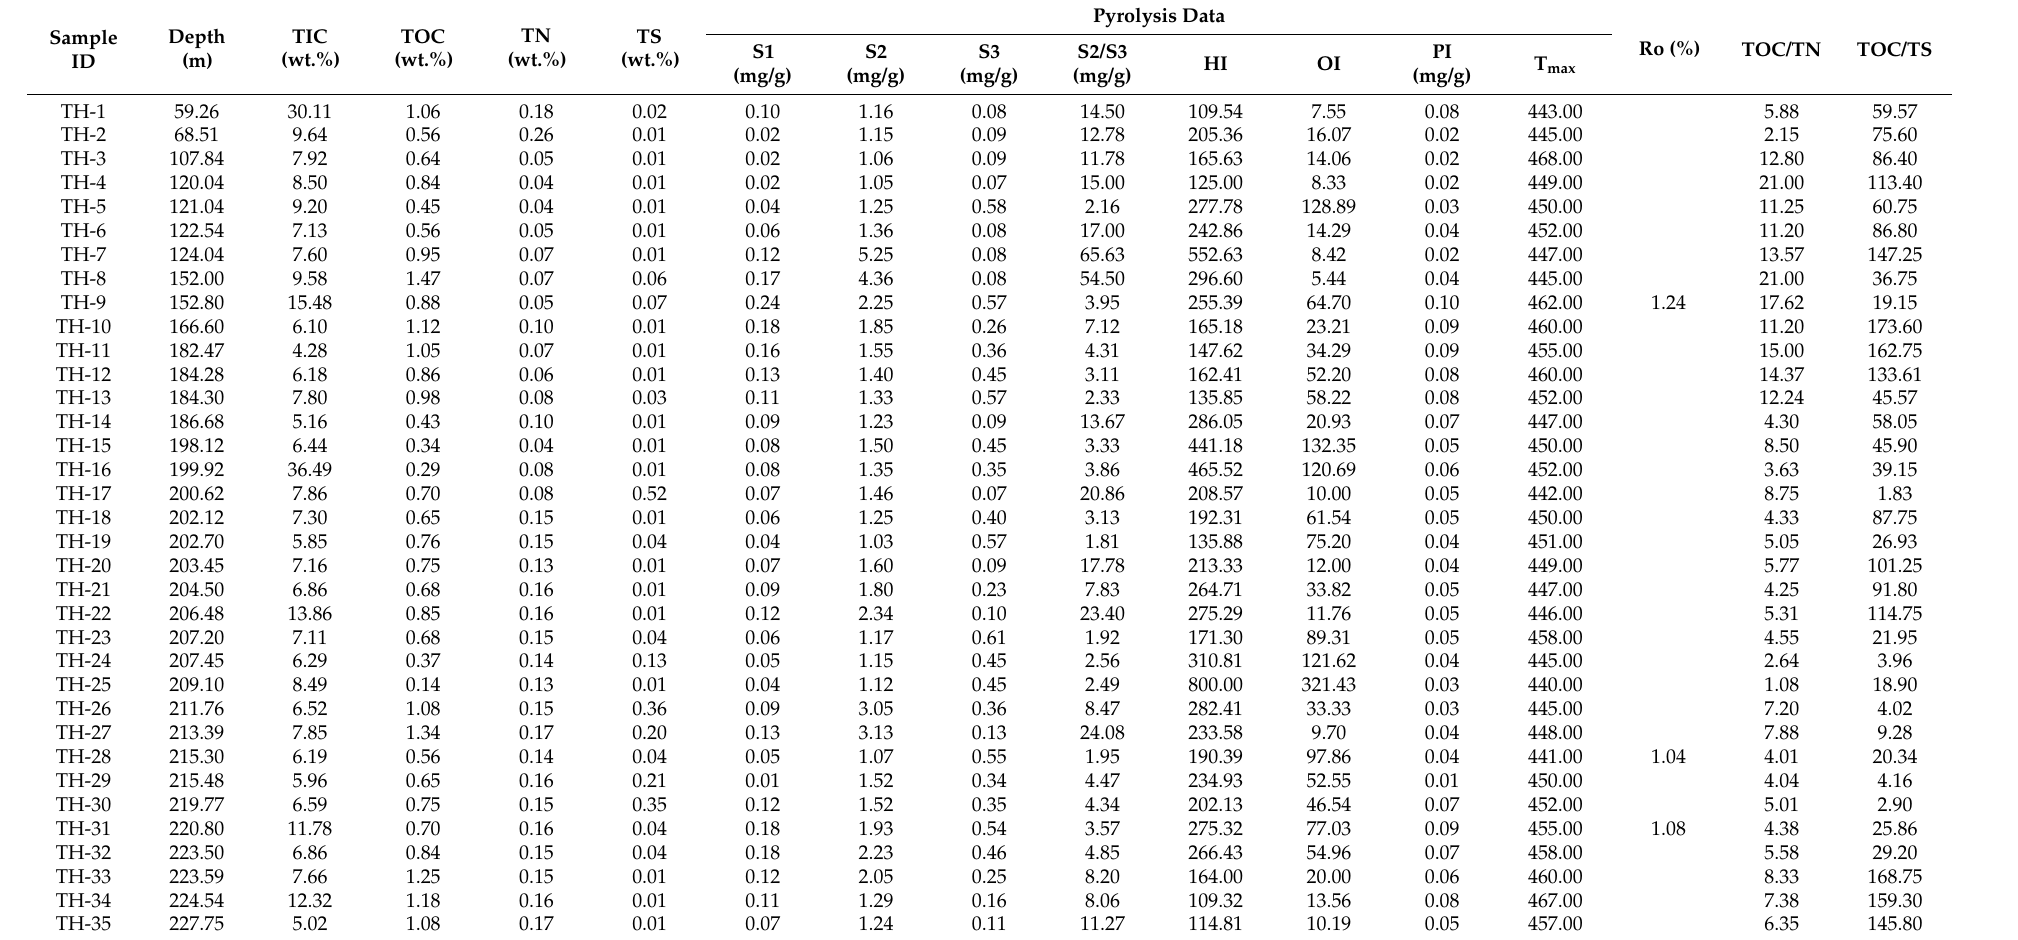
Table 2. Bulk geochemical parameters of the samples from the Hengtongshan